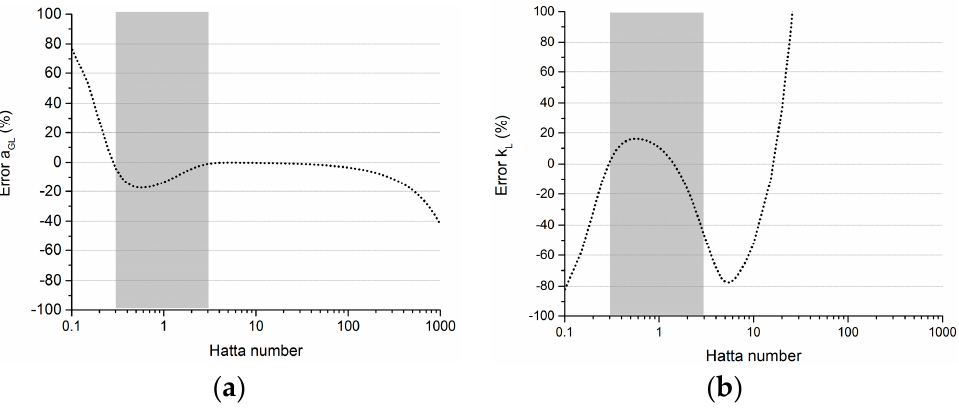
Figure 4. Percentage error in the estimation of ( a ) interfacial area ( a GL ) and ( b ) mass-transfer coefficient ( k L ) using the Danckwerts’ plot over a wide range of Ha for a Bubble column, ε l /( a GL · δ ) = 1000.